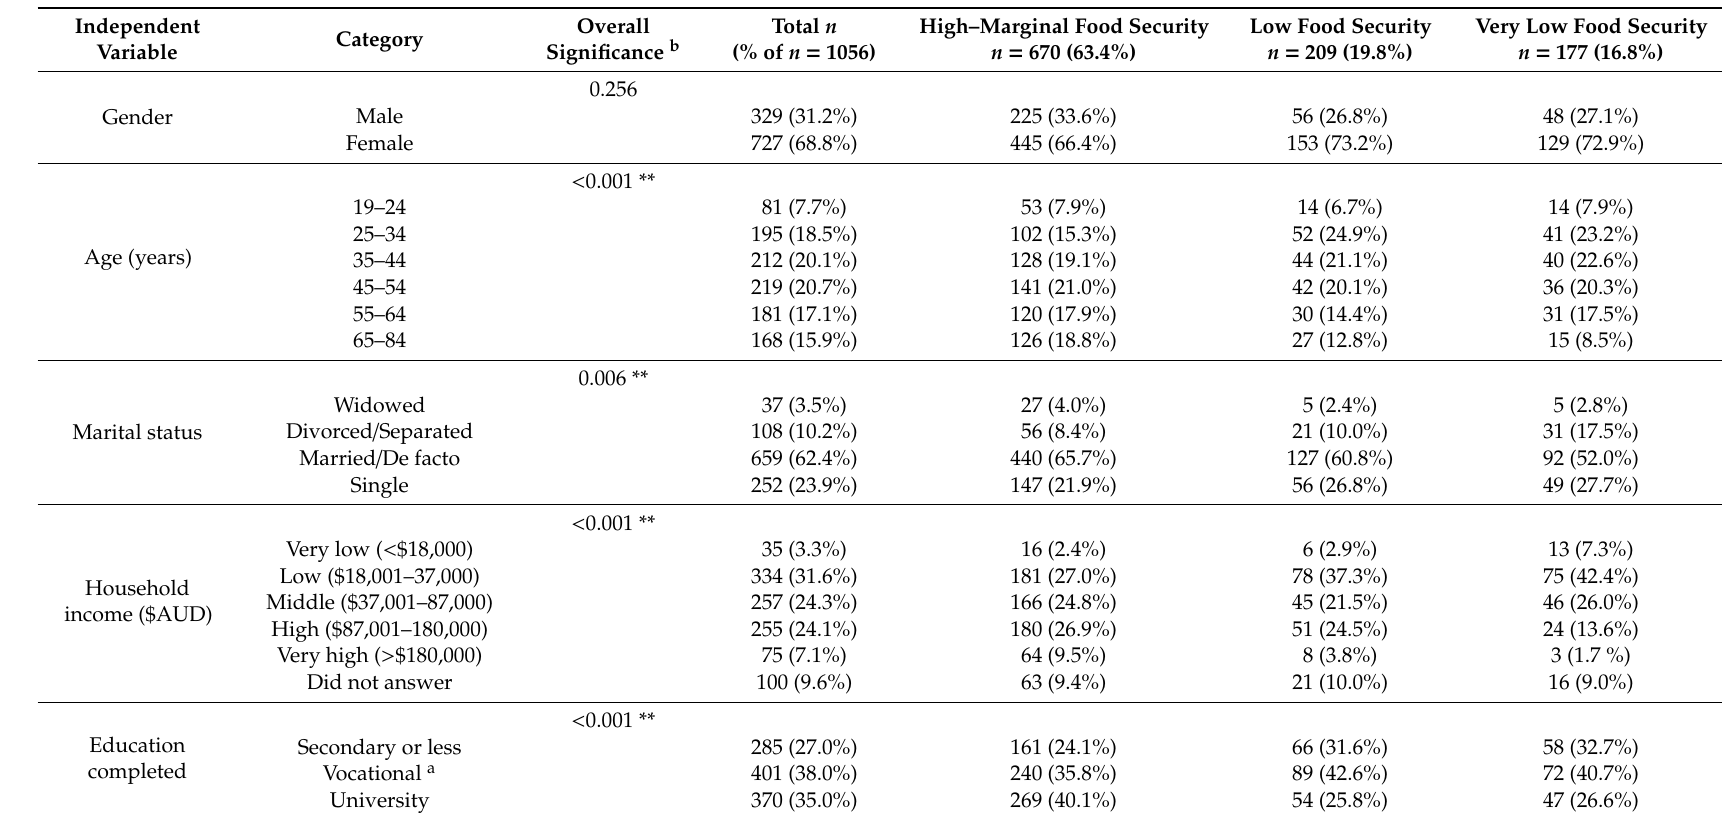
Table 1. Characteristics of survey respondents compared by food security